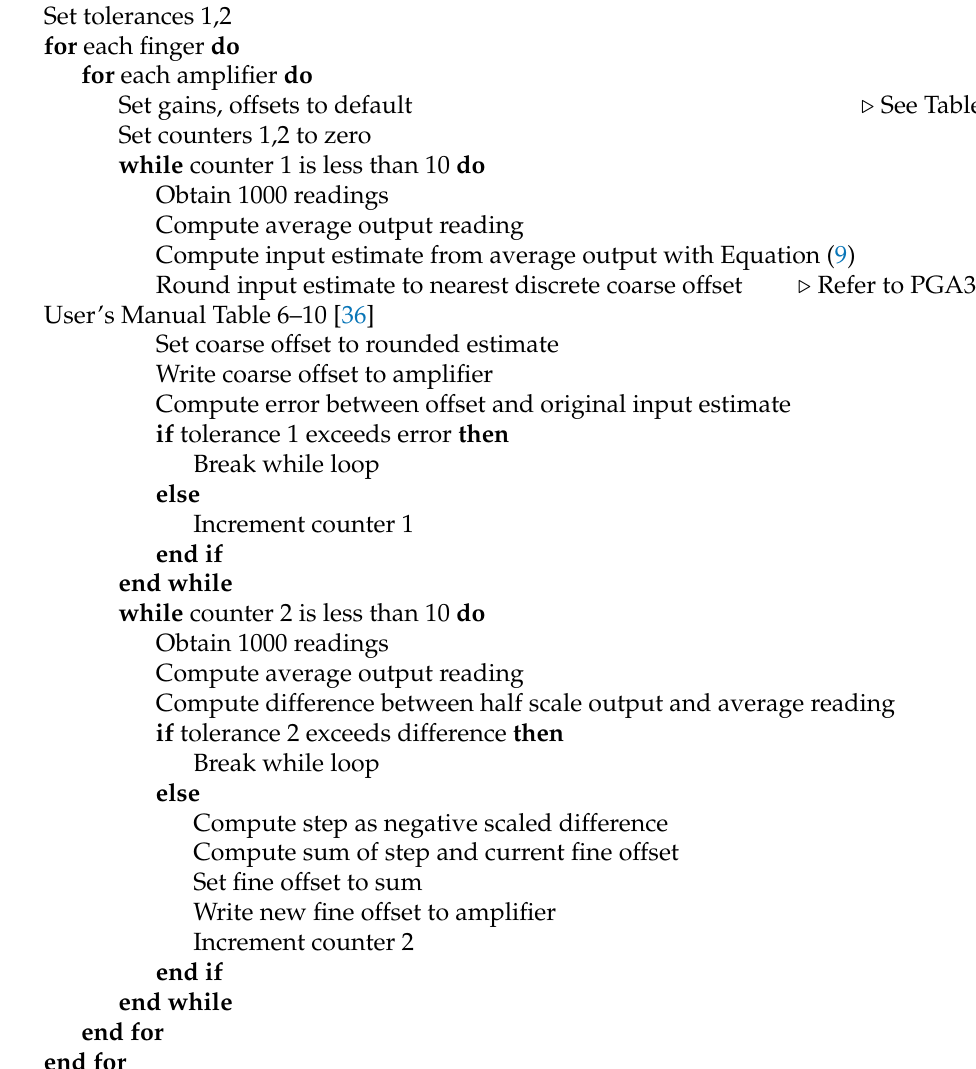
Algorithm 1 Procedure for tareing sensor readings via writing amplifier settings